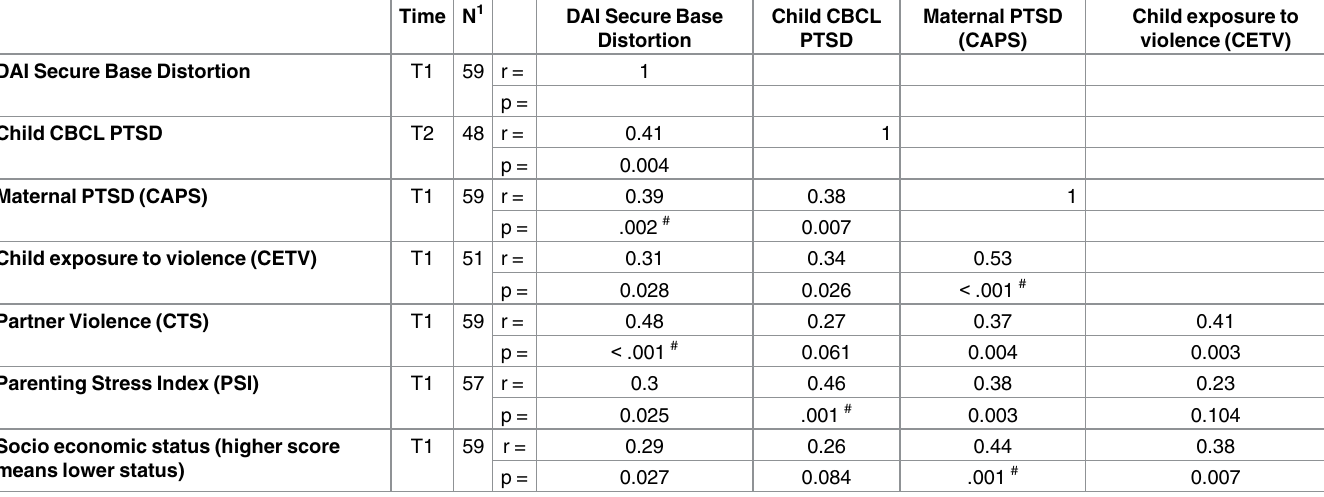
Table 2. Correlation matrix of maternal and child measuresat T1 and